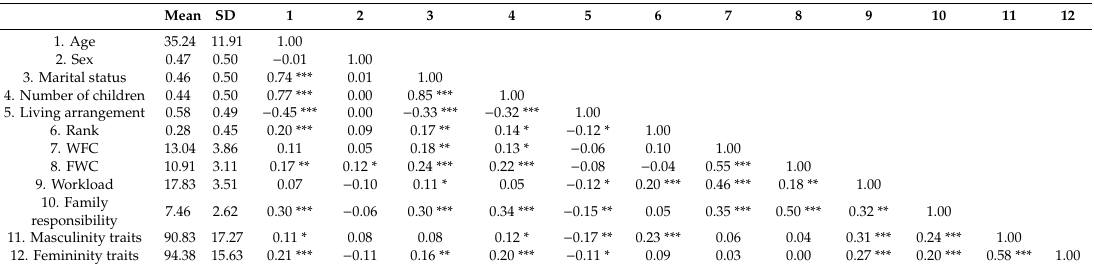
Table 1. Interrelations among research variables ( N =